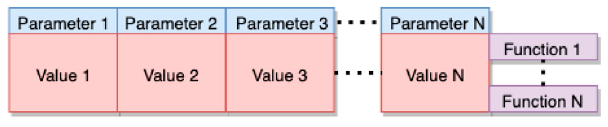
FIGURE 2 | Individual vector for representation of the tunable